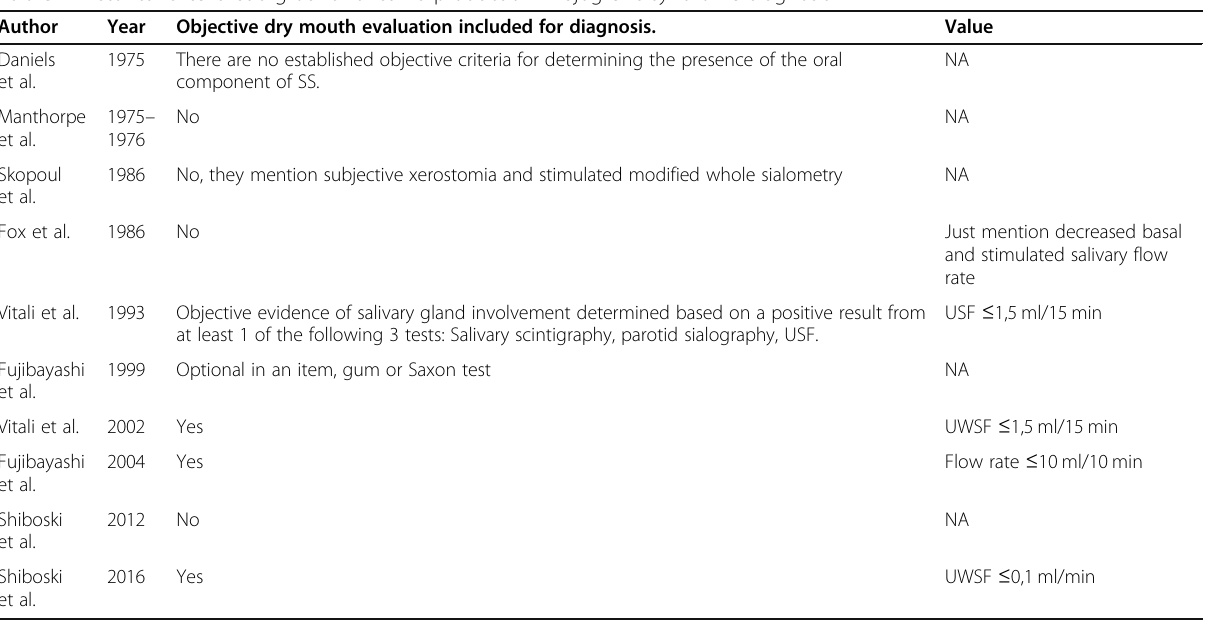
Table 4 Historical criteria background for saliva production in Sjögren ’ s syndrome diagnosis